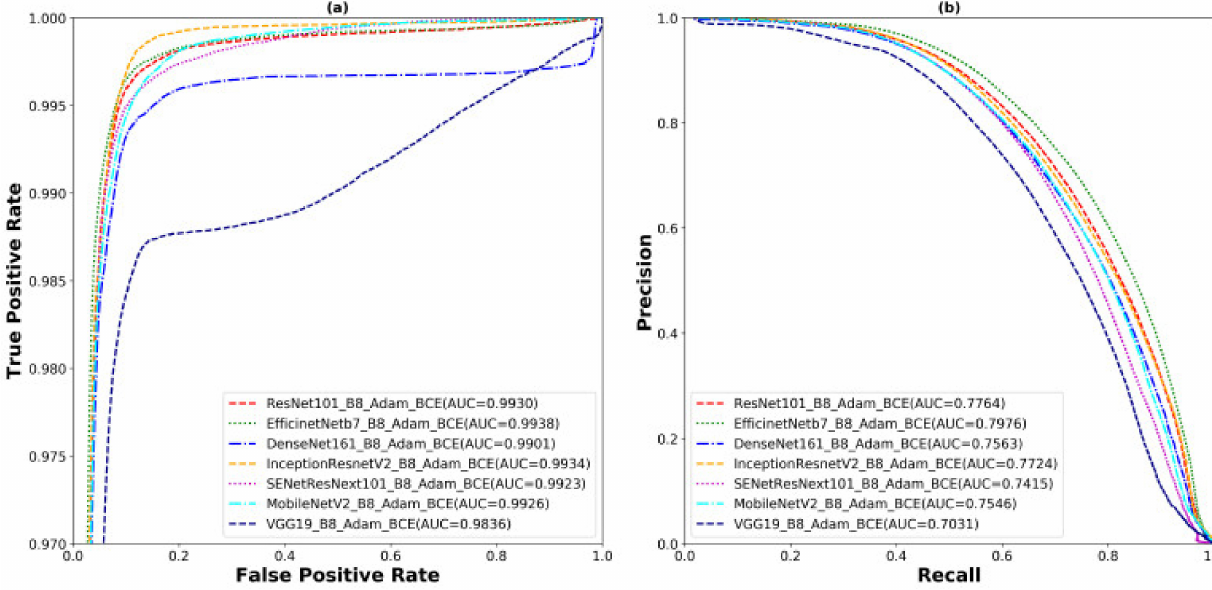
Figure 7. The ( a ) ROC and ( b ) PR carve for the experiment of the U-Net model with different backbones, the Adam optimizer, BCE loss function, and the batch size of